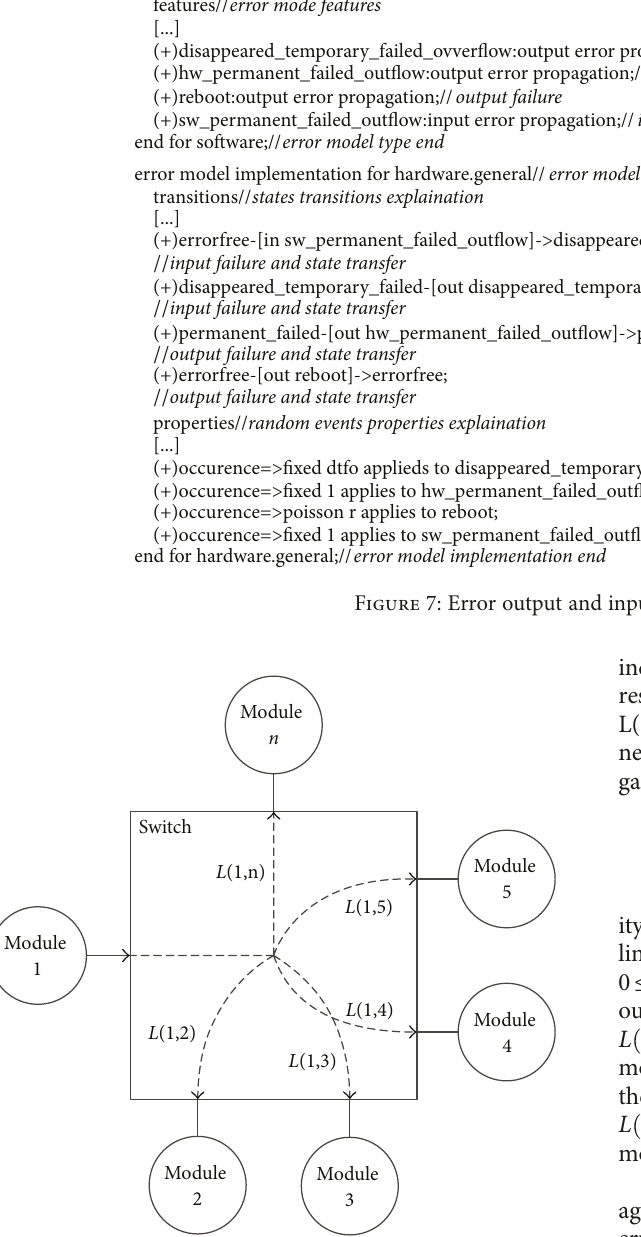
Figure 8: Error propagation simpli fi ed model of